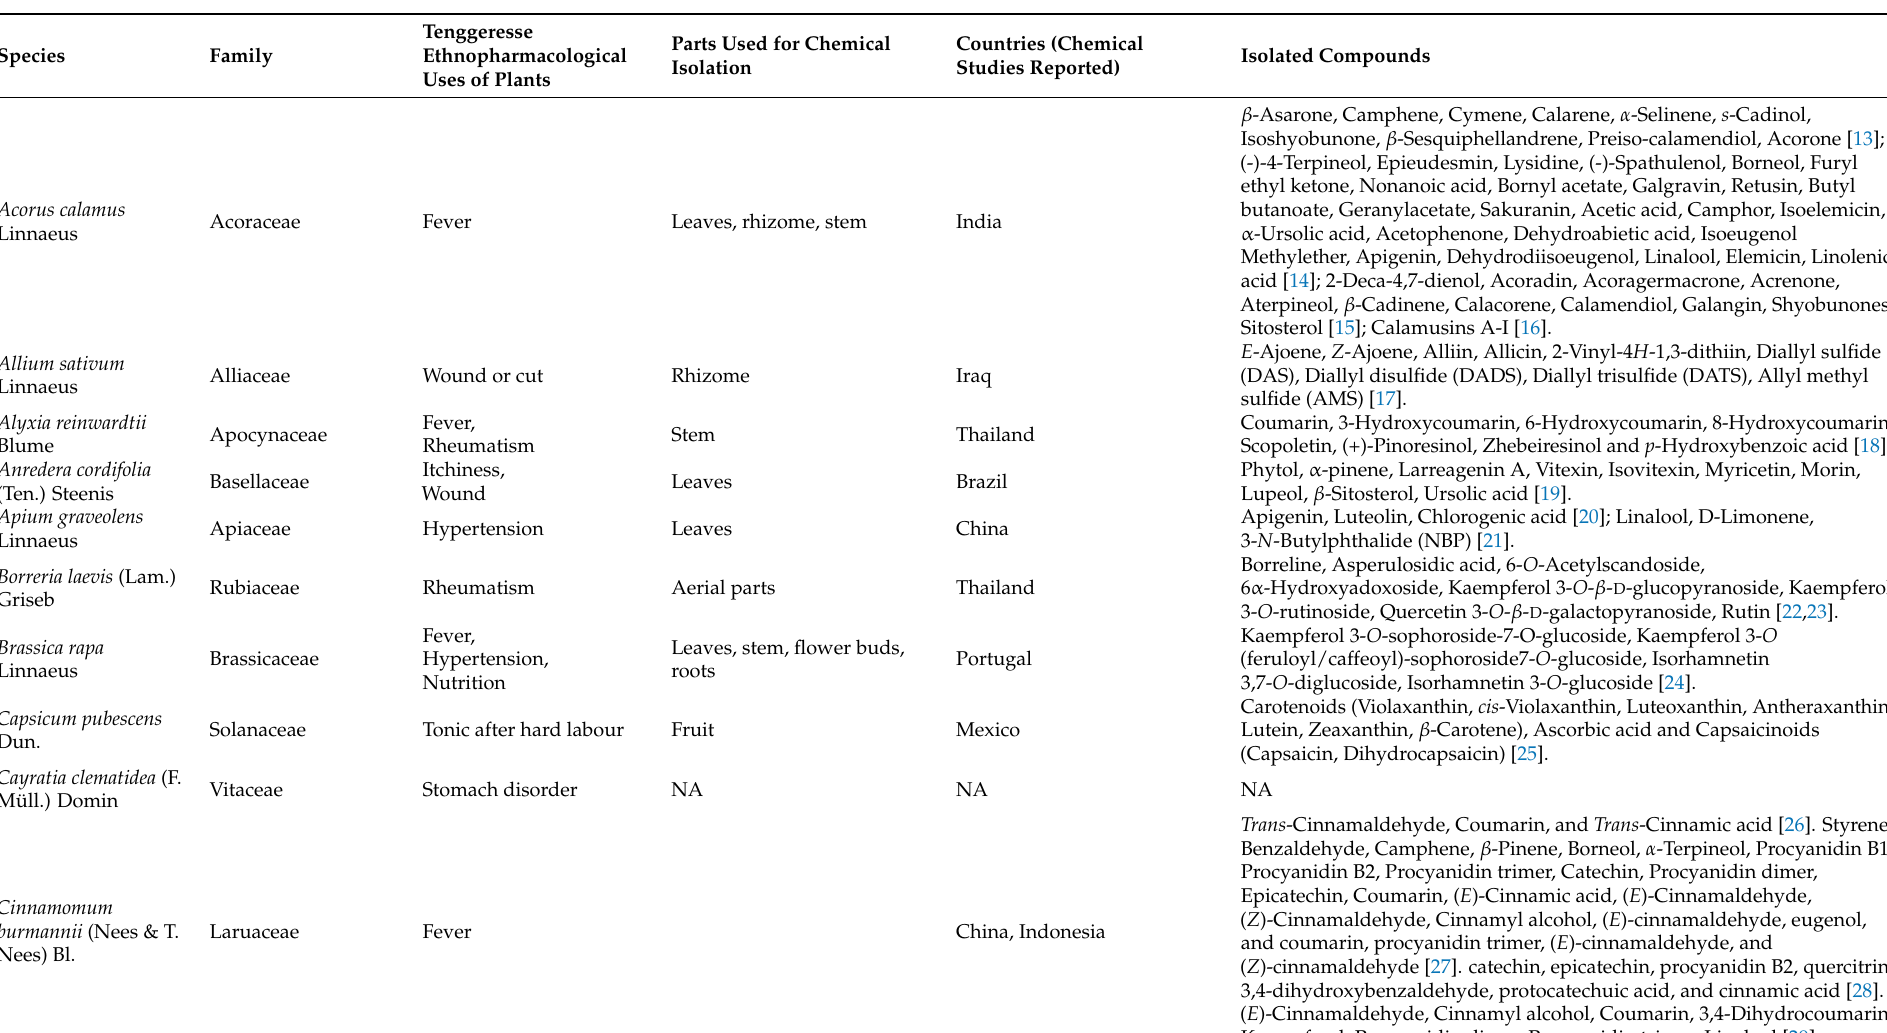
Table 1. Phytochemistry of Tenggerese medicinal plants collated from literature studies of similar species studied across the